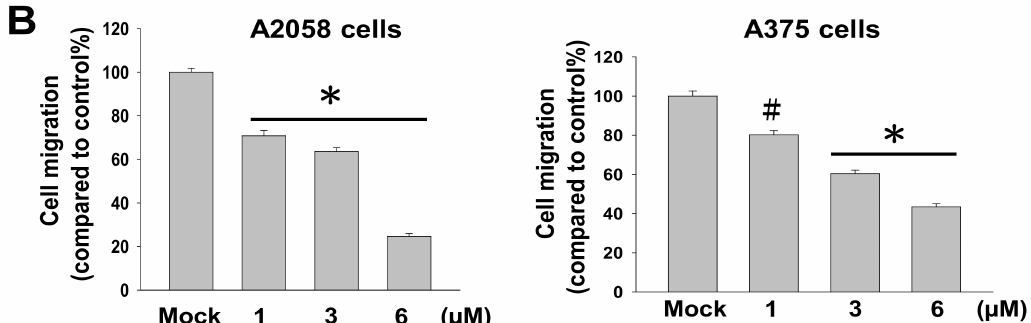
Figure 2. The effects of bornyl cis -4-hydroxycinnamate on A2058 and A375 cell migration. ( A ) After 24 h of treatment with bornyl cis -4-hydroxycinnamate, the percentages of migrated A2058 and A375 cells were significantly reduced in comparison with the controls (Mock: cells treated with vehicle DMSO). Scale bars = 20 µ m. The results shown here are representative of three independent experiments; ( B ) Quantitative analysis of three independent experiments showed that bornyl cis -4-hydroxycinnamate suppressed A2058 and A375 cell migration in a dose-dependent manner (# p < 0.05, * p < 0.001 as compared with controls). Results were from three independent experiments in triplicate in each experiment.